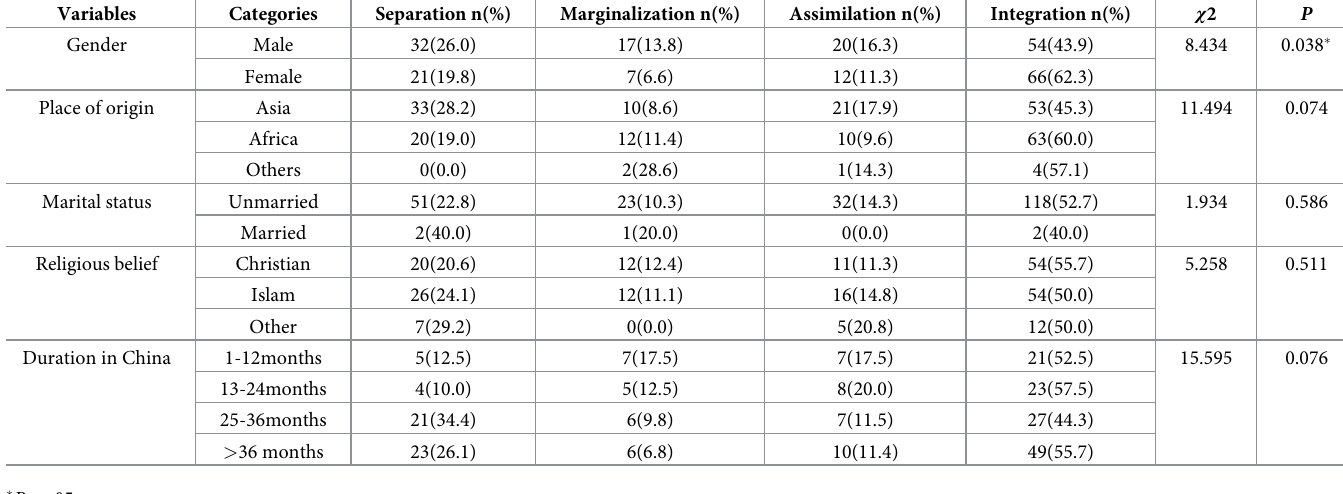
Table 1. Demographic characteristics of study